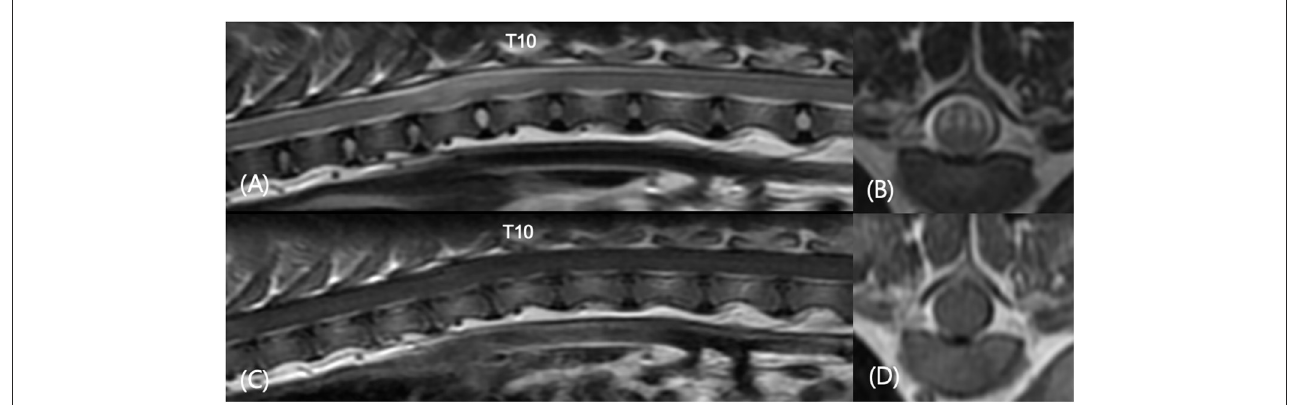
FIGURE5 Sagittal T2-weighted (A) , transverse T2-weighted T9-T10 (B) , sagittal T1-weighted post-contrast (C) , and transverse T1-weighted post-contrast T9–T10 (D) images in a 3-year-old castrated male in Table 4 (number 8). The patient showed progressive pelvic limb ataxia, urinary retention, and fecal incontinence for 2 years. MRI revealed spinal myelopathy with mild malalignment at T9–T11. No significant findings were found in contrast enhanced images. There were caudal articular process dysplasia at T5, T8, T9, and T11 in CT